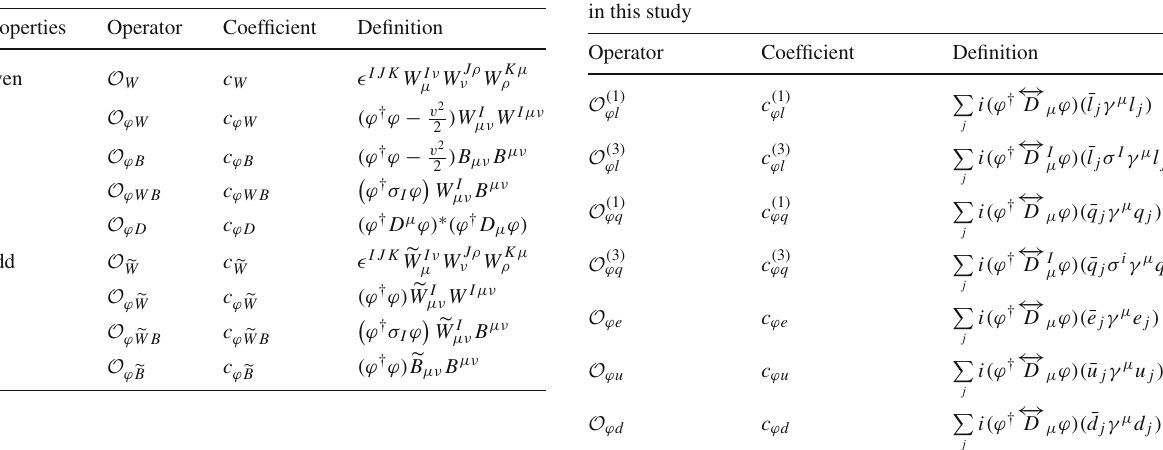
Table 1 Dimension-six purely bosonic operators that modify the inter- actions of the electroweak gauge bosons. For each operator, we indicate its definition in terms of the SM fields, and the notational conventions that will be used both for the operator and for the Wilson coefficient